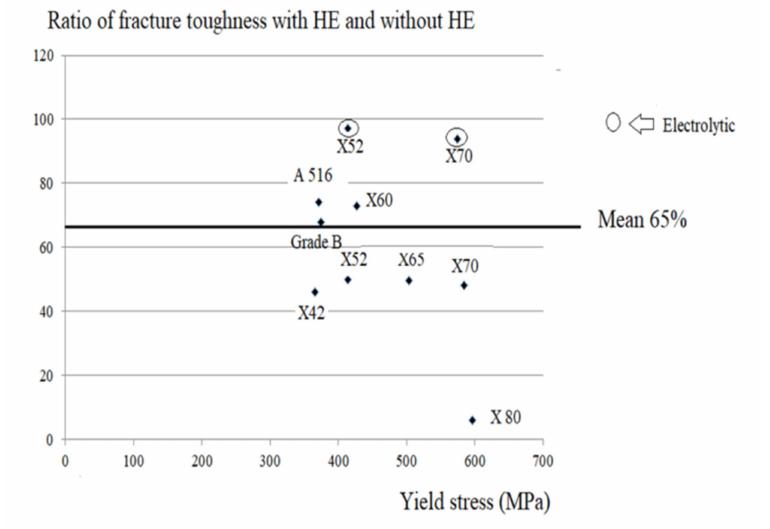
Figure 5. Evolution of fracture toughness ratio under the influence of HE for several pipe